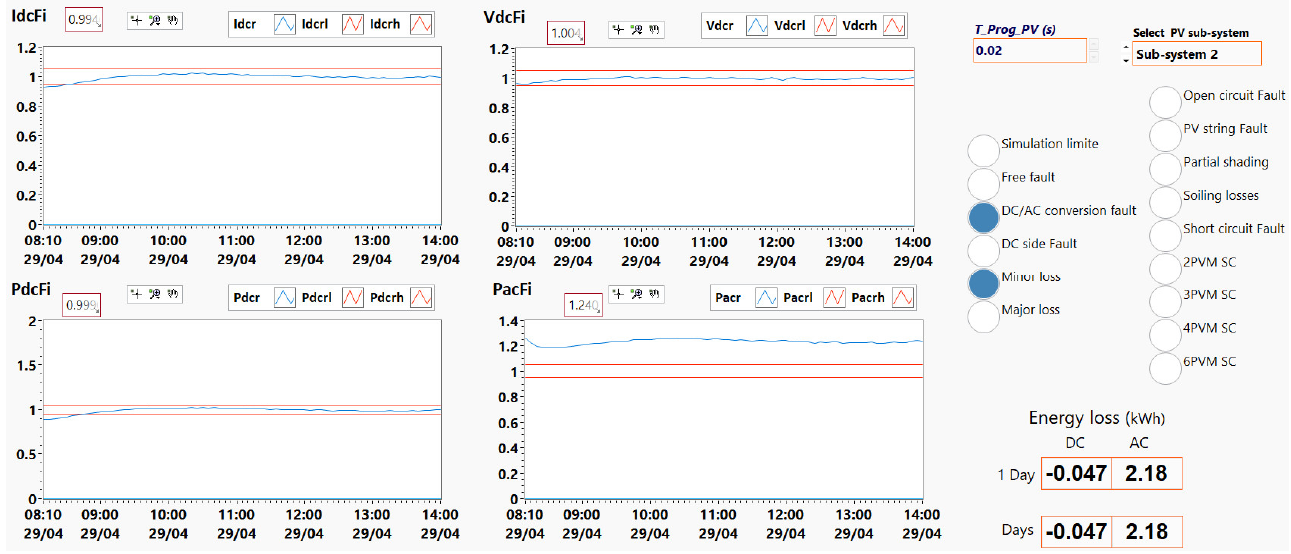
Figure 34. Detection and classification of the DC/AC inverter efficiency fault.